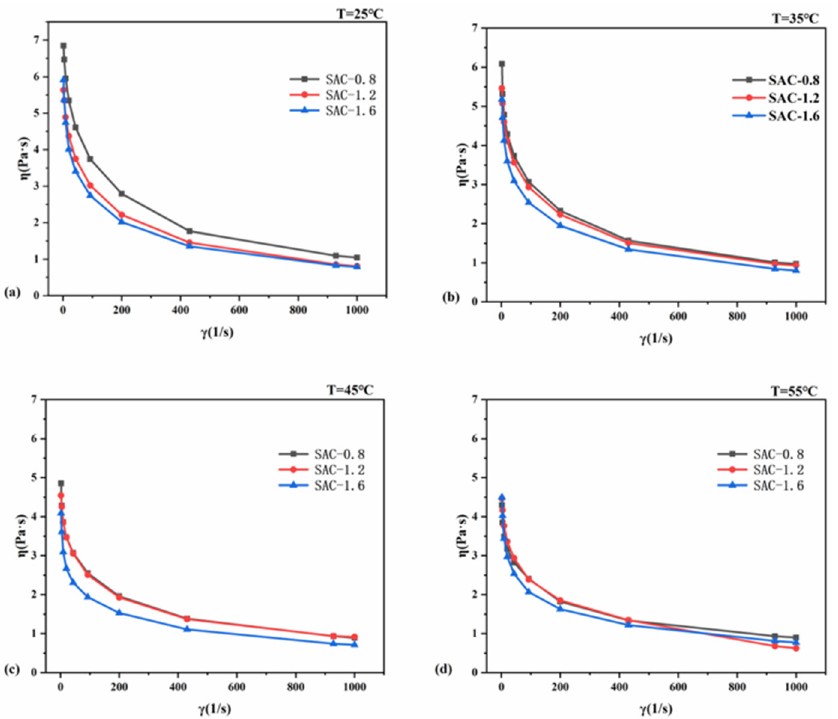
Figure 1. Relationship between η and γ of SA/AKP/CNCs composite solution at different spinning temperature ( a ) T = 25 ◦ C, ( b ) T = 35 ◦ C, ( c ) T = 45 ◦ C, ( d ) T = 55 ◦ C. The curves of shear stress and shear rate (lg τ -lg γ ) of three groups of spinning stock solution were made of different temperatures, the slope was non-Newtonian index (Table 1) and the formula was as follow. 𝜏 = 𝐾𝛾(cid:4662) (cid:3041) Table 1. The non-newtonian index of SA/AKP/CNCs composite solution.